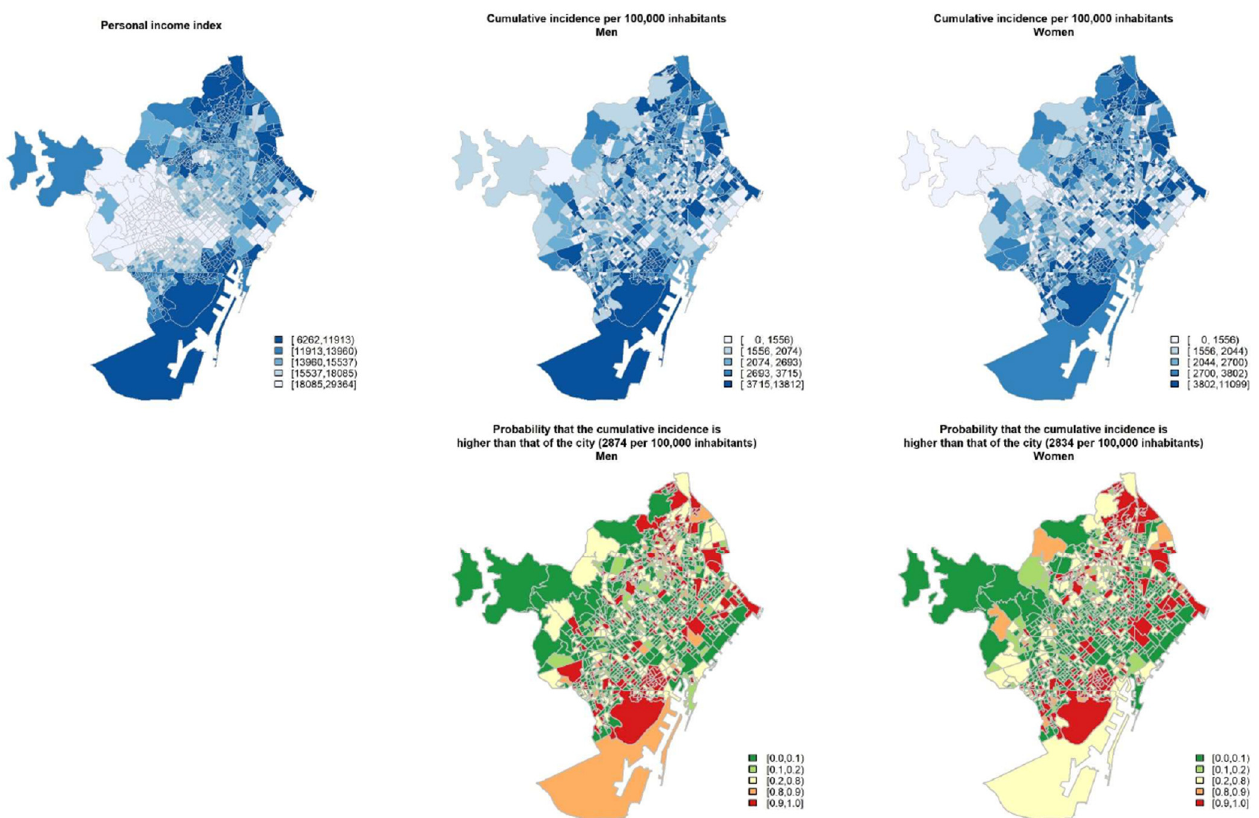
Figure 4. Geographical distribution (at census tract level) of 2016 personal income index (in Euros), cumulative incidence of COVID-19 per 100,000 inhabitants according to sex, and probability of the cumulative incidence being higher than that of the city. Period from 16 July to 30 November 2020 in Barcelona city.